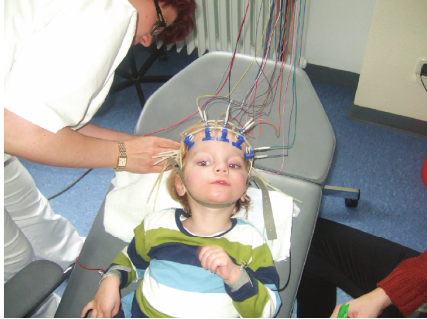
Figure 2: EEG recording (L.B.) before transplantation. The patient (L.B.) is in a persistent vegetative state 9 weeks after the insult before transplantation of cord blood cells. Note the dilated, unresponsive pupils in spite of bright light from the